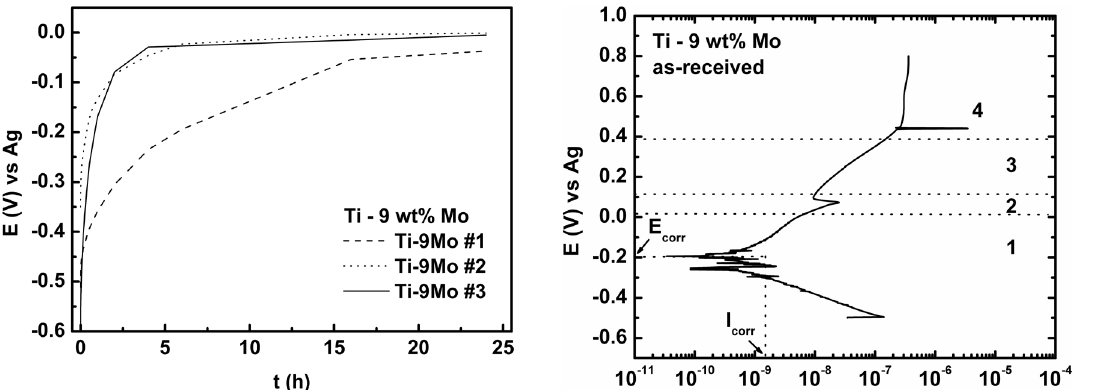
Figure 3. Potential variation with time for Ti-9Mo alloys in different conditions. Measurements carried out at room temperature (25 ± 1 ºC).